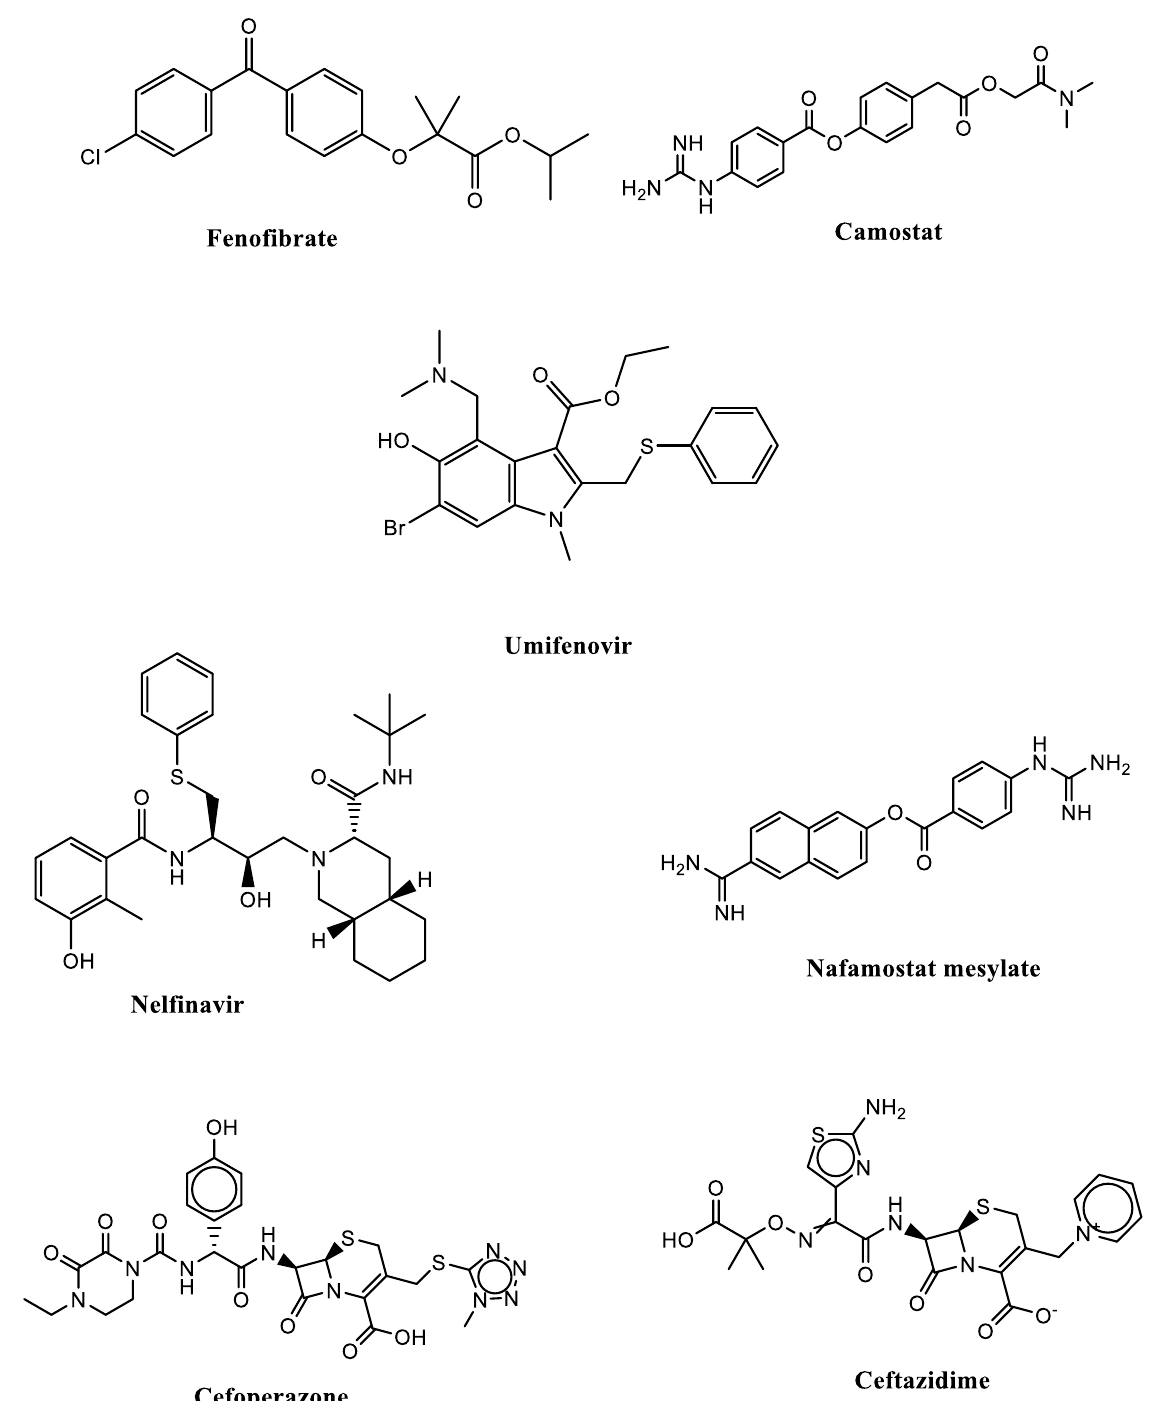
Figure 1. Potential SARS-CoV-2 S1 glycoprotein repurposed FDA approved drugs.